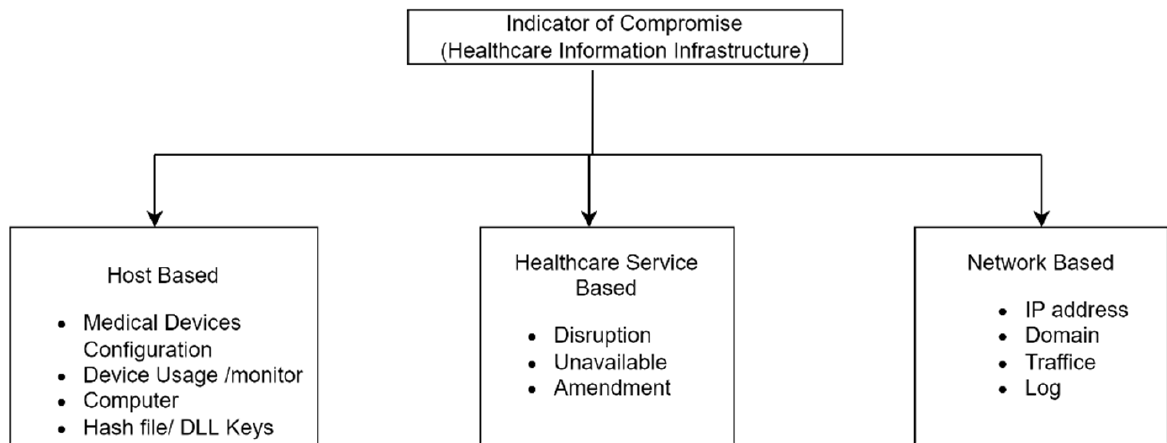
Figure 2. Possible IoCs for healthcare information infrastructure.